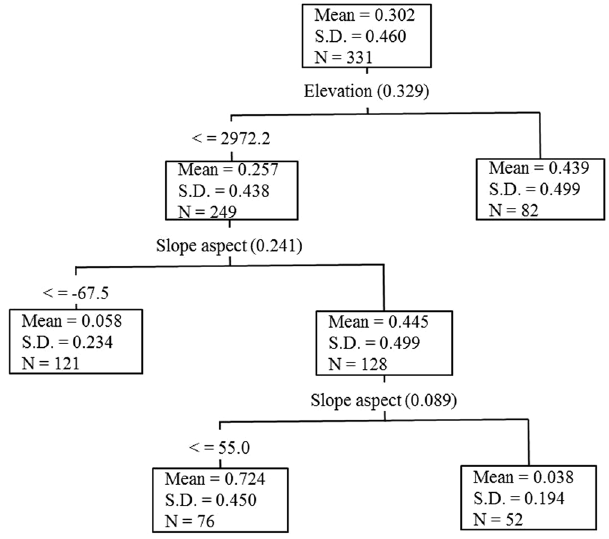
Figure 3. Regression tree predicting distribution of Qinghai spruce forests (and non-forest vegetation) from limiting factors (PRE = 0.659). Each node (square) is labeled with average forested ratio (mean), standard deviation (S.D.) and the number (n) of spatial units in that group. The model is read from top down until terminal nodes appear. Partial PRE values are presented in parentheses at each root node to split. This map was generated using SYSTAT 13 (Systat Software, San Jose,